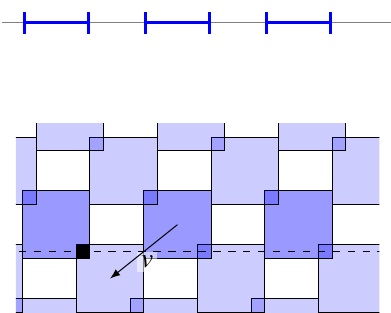
Figure 4: In the case where the rate is smaller than 1 / 2, there is not necessarily new intersections between times k and k +